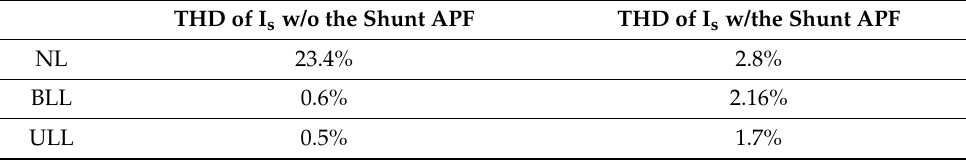
Table 2. THD of the source currents (I s ) without and with the shunt APF.